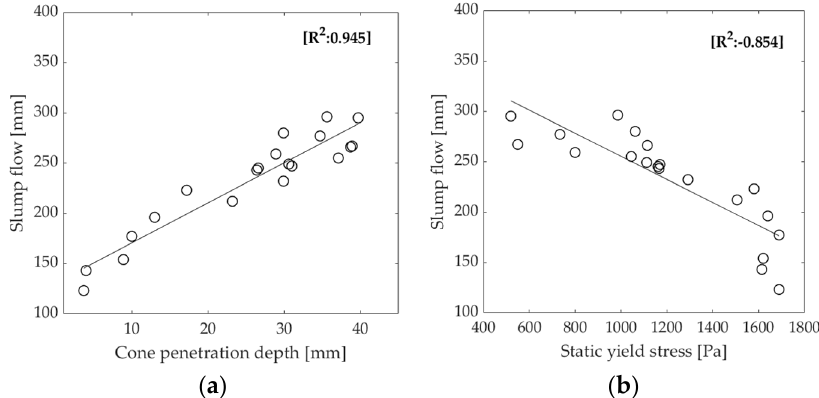
Figure 5. ( a ) Correlation between slump flow and penetration depth, and ( b ) correlation between slump flow and yield stress for all mortar mixes in this experiment (mix 1 − 20).